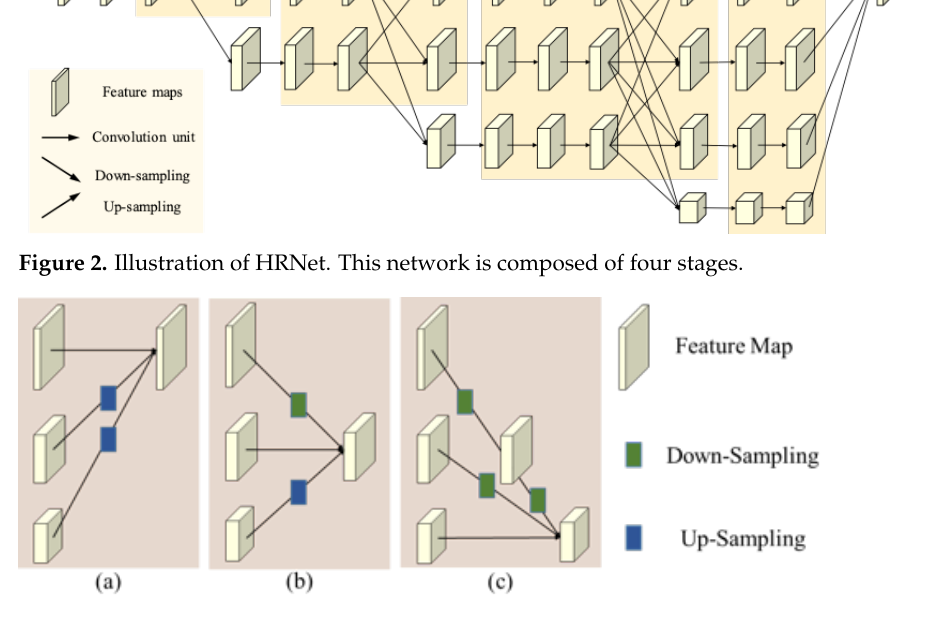
Figure 3. Tensor fusion module information exchange across different resolutions: ( a ) illustrates the fusion of high resolution, ( b ) illustrates the fusion of medium resolution, and ( c ) illustrates the fusion of low resolution. The downsampling is implemented by 3 × 3 convolution, the stride of which is 2. The upsampling is implemented by bilinear interpolation.